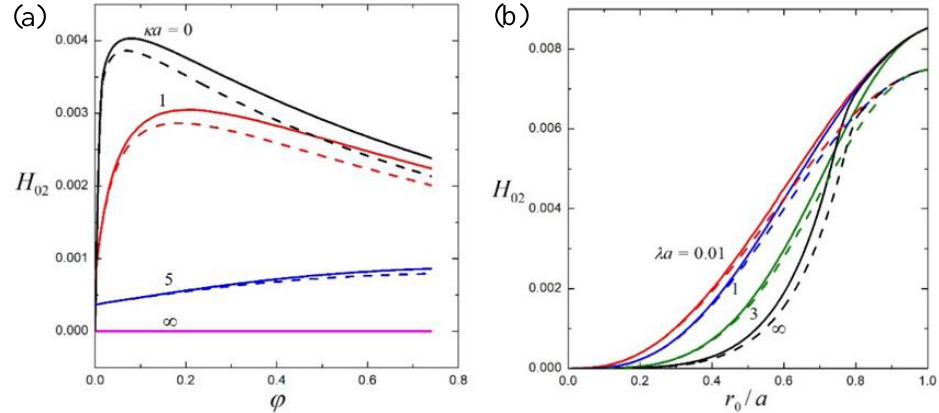
= a λ Figure 6. The electrophoretic mobility coe ffi cient H 10 for a suspension of soft spheres: ( a ) λ a = 1 and Figure 6. The electrophoretic mobility coefficient 10 H for a suspension of soft spheres: ( a ) 1 r 0 / a = 0.5; ( b ) κ a = 1 and ϕ = 0.1. The solid and dashed curves represent the calculations for the =ϕ and and 0.1 . The solid and dashed curves represent the Happel and Kuwabara models, respectively. calculations for the Happel and Kuwabara models, respectively.